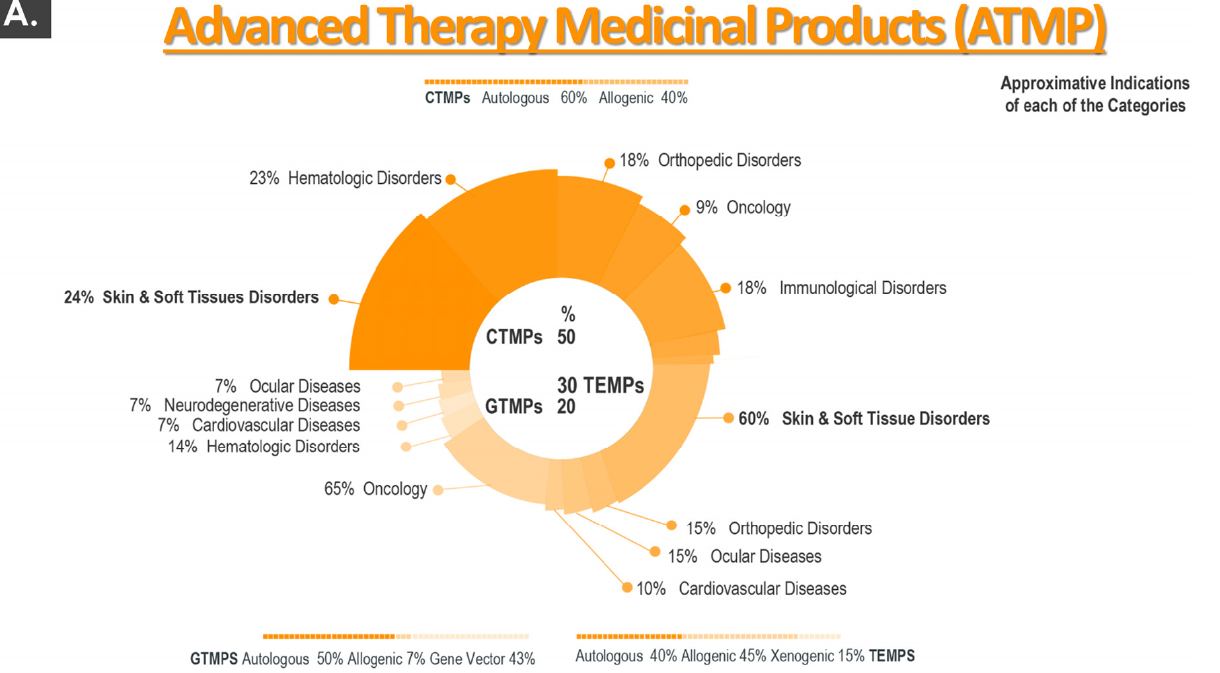
Figure 1. Overview of the current global cytotherapy ecosystem, with a focus on ATMPs for cuta ‐ neous application. ( A ) The upper portion of the figure presents a condensed summary of the avail ‐ able ATMPs, distributed into both product sub ‐ categories and therapeutic indications. ( B ) The lower